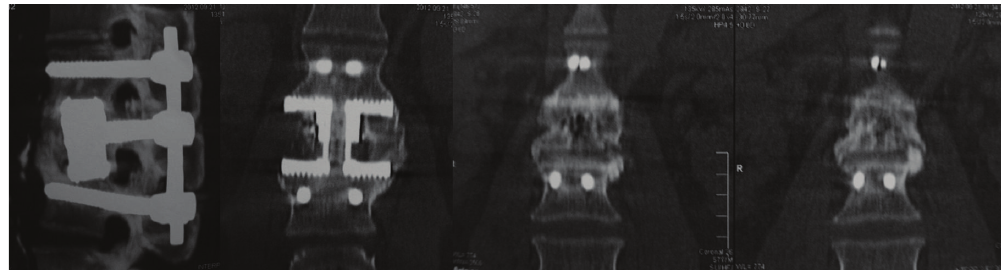
Figure 4: CT scan showing solid fusion 24 months after the procedure. The device design promotes the ossification inside and outside of the